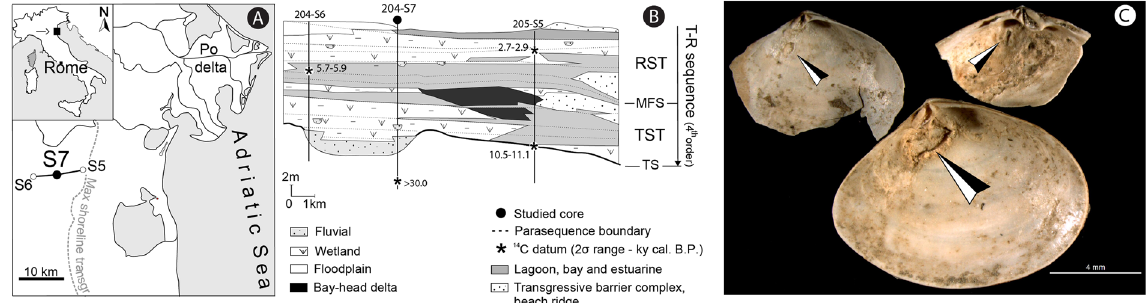
Figure 1. Location map, cross-section, and images of parasitized Abra segmentum valves. ( A ) Location map of investigated Po coastal plain sector, Italy ( B ) Schematic cross section (along dip) illustrating the stratigraphic stacking of facies across the investigated portion of the Holocene post-Last Glacial Maximum T-R sequence and location of the 204-S7 core. ( C ) Photomicrographs of A. segmentum with trematode-induced pits (black/white arrows). TS: transgressive surface, TST: transgressive systems tract, MFS: maximum flooding surface, RST: regressive systems tract, T-R: